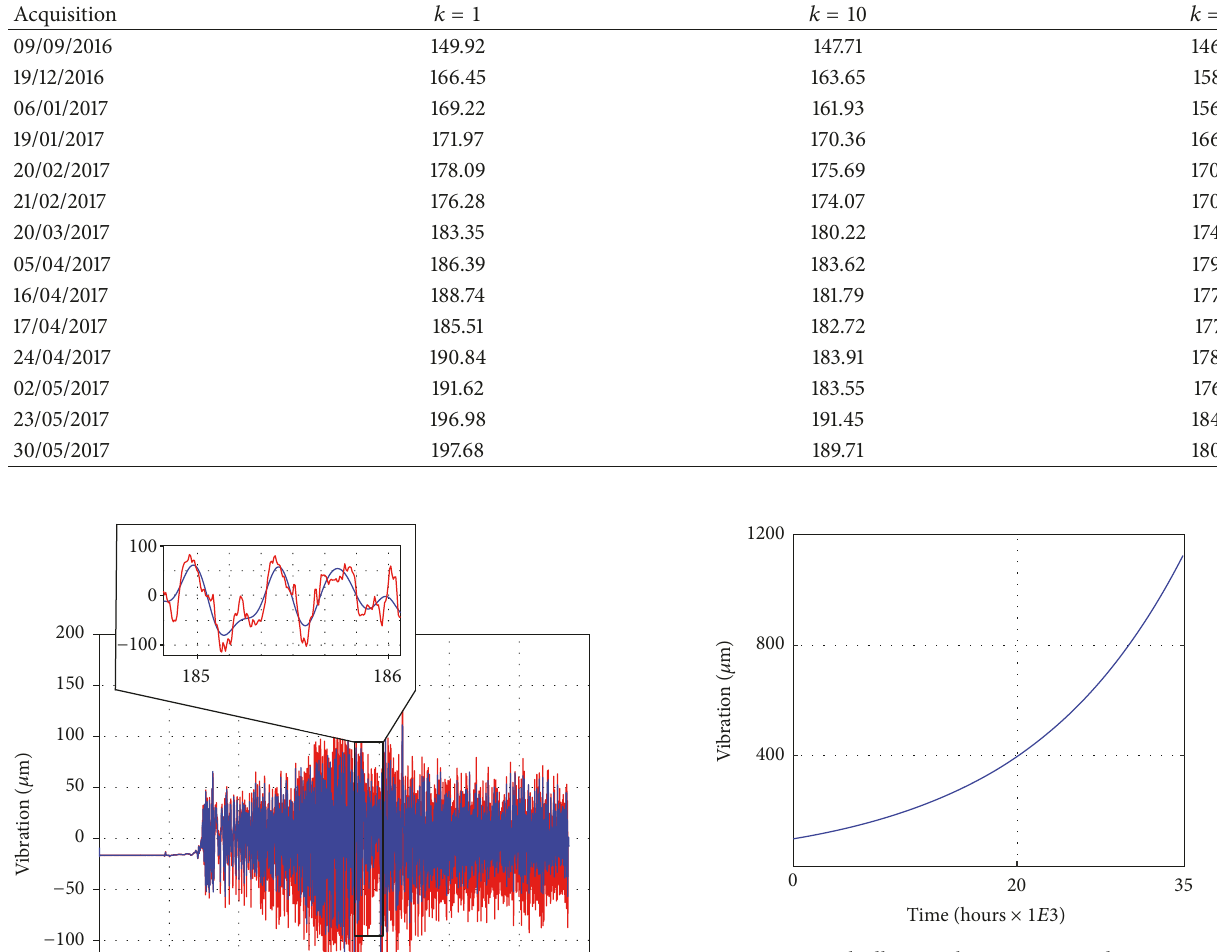
Figure 7: Exponential adherence between 𝑆 max and operation